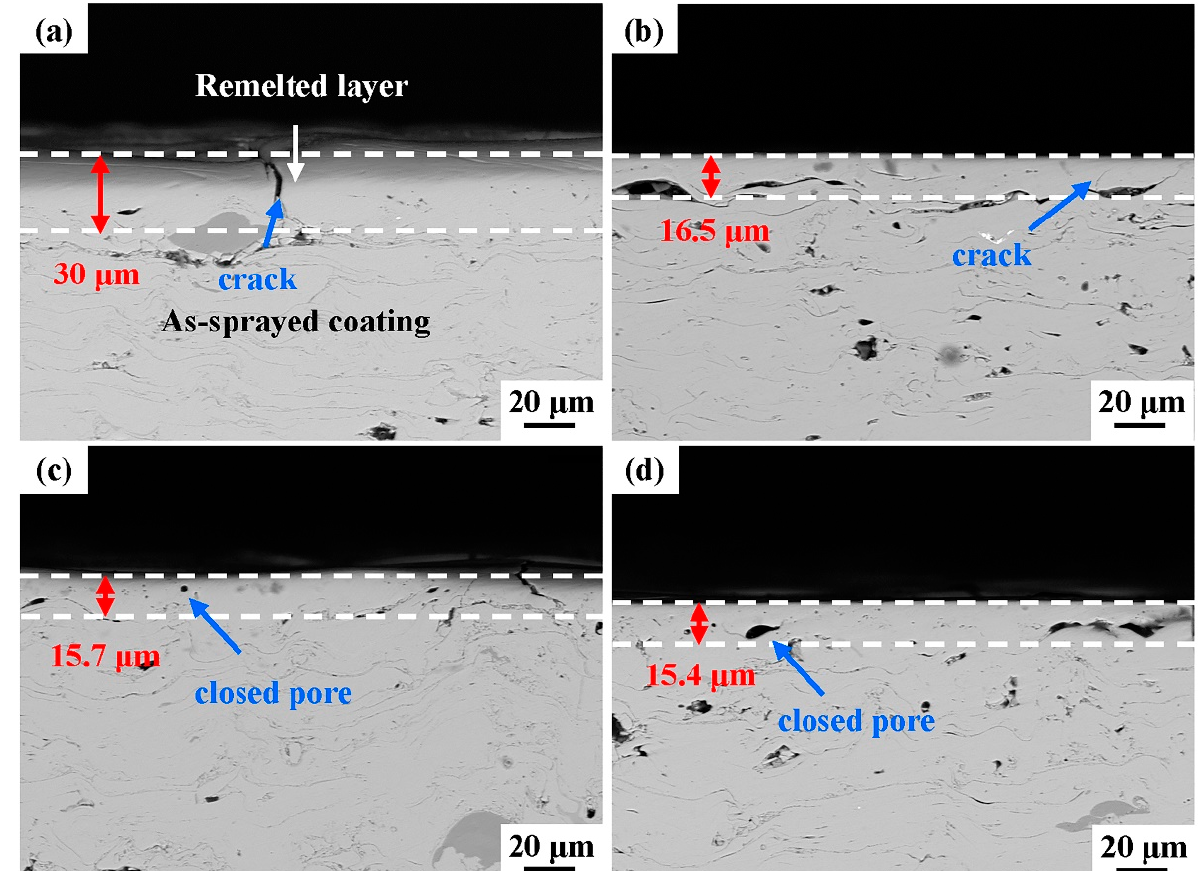
Figure 6. Cross ‐ sectional morphologies of the laser ‐ processed coating samples at different scanning Figure 6. Cross-sectional morphologies of the laser-processed coating samples at different scanning frequencies: ( a ) 60 Hz, ( b ) 80 Hz, ( c ) 100 Hz, ( d ) 120 Hz. frequencies: ( a ) 60 Hz, ( b ) 80 Hz, ( c ) 100 Hz, ( d ) 120